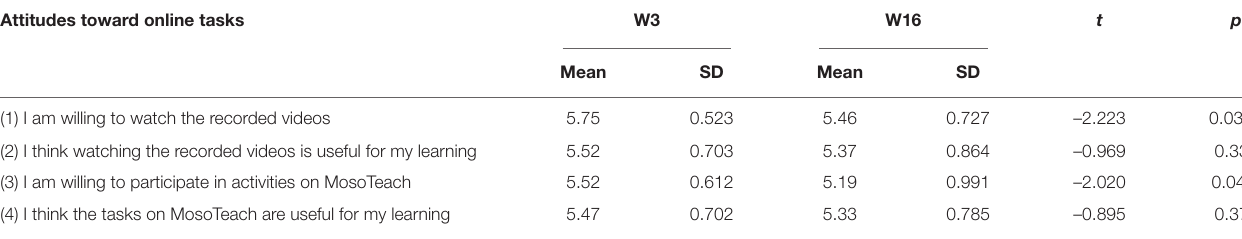
TABLE 2 | Students’ attitudes toward online SRL tasks. Attitudes toward online